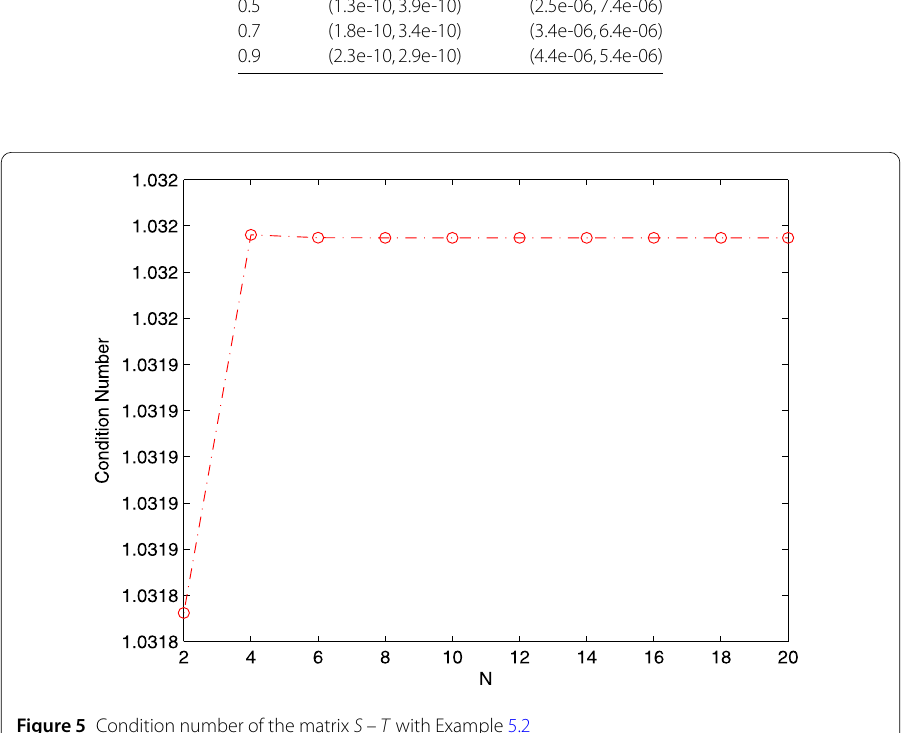
Figure 5 Condition number of the matrix S – T with Example 5.2